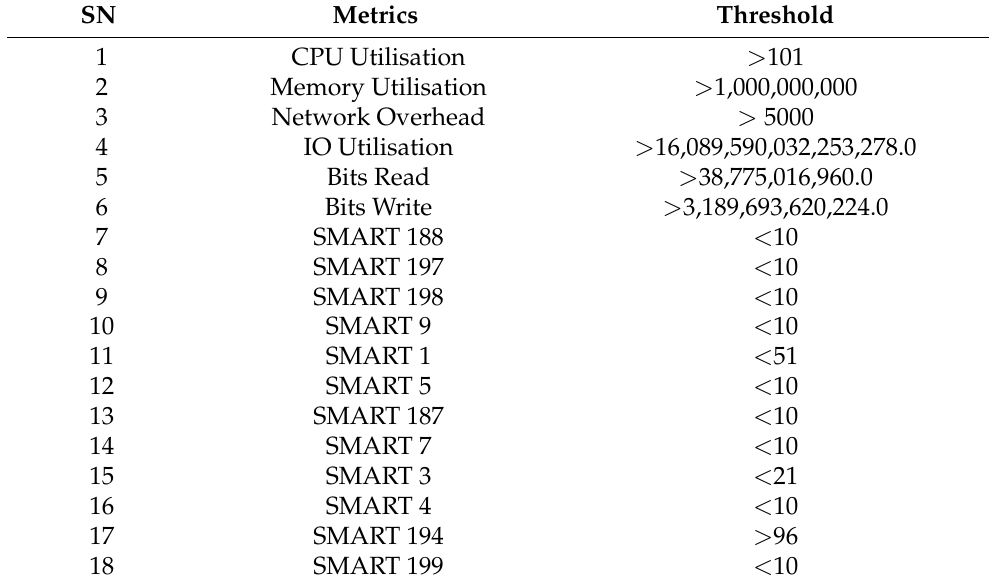
Table 3. Metrics and threshold used in